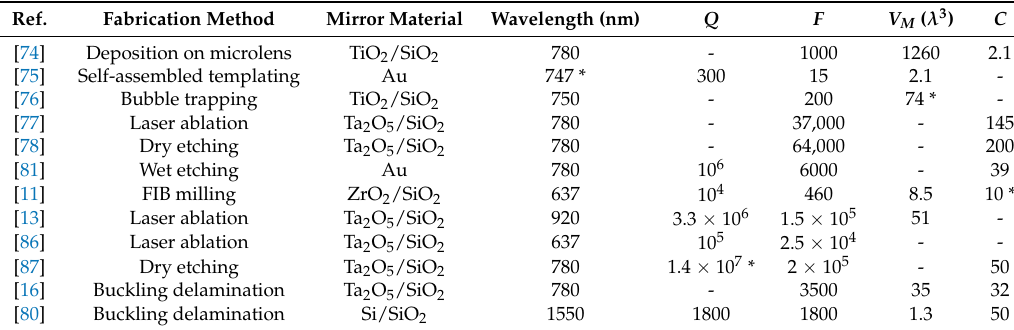
Table 2. Summary of chip-based, curve-mirror FPCs proposed for